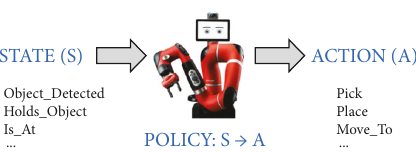
Figure 2: Action